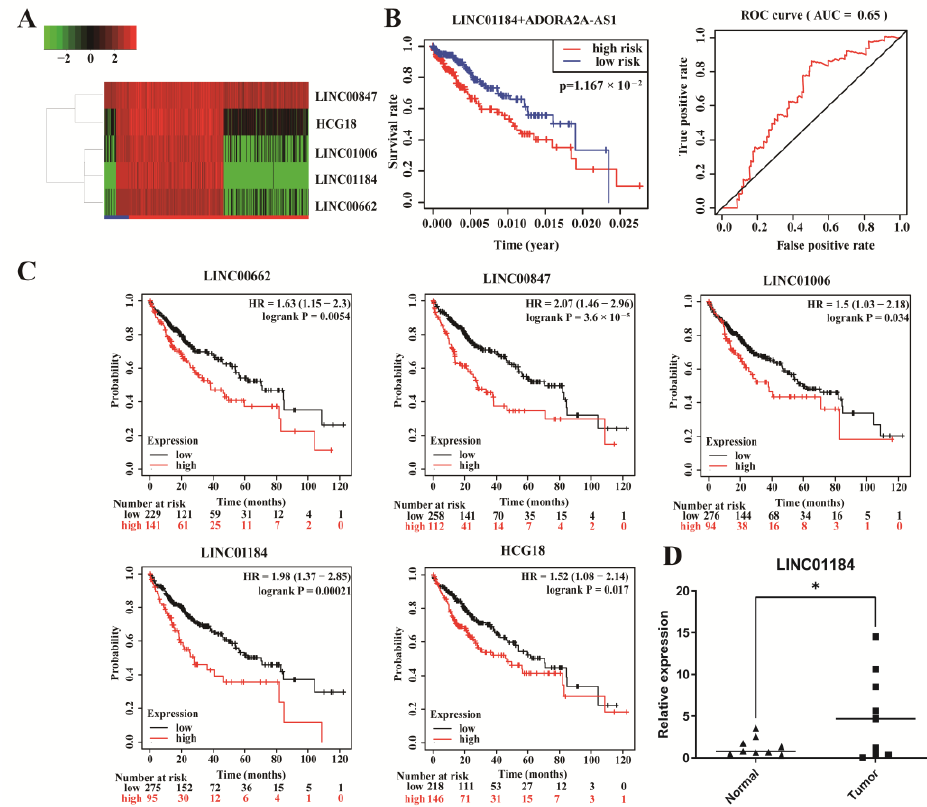
Figure 7. Comprehensive analysis for the 133 lncRNAs in HCC ( A ) Heatmap of the 5 key lncRNAs expression. ( B ) Kaplan–Meier survival analysis and ROC curve validation of two lncRNA signatures based on risk scores. ( C ) Kaplan–Meier survival analysis of five lncRNAs. ( D ) Expression patterns of LINC01184 in HCC and paracancerous tissues (Normal: n = 9; Tumor: n = 9). Data are shown as means ± SD, * p < 0.05.